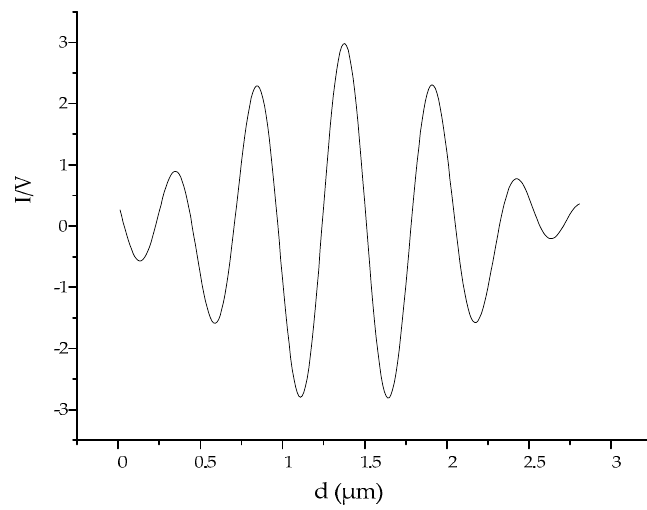
Figure 5. Theoretical white light interference signal.